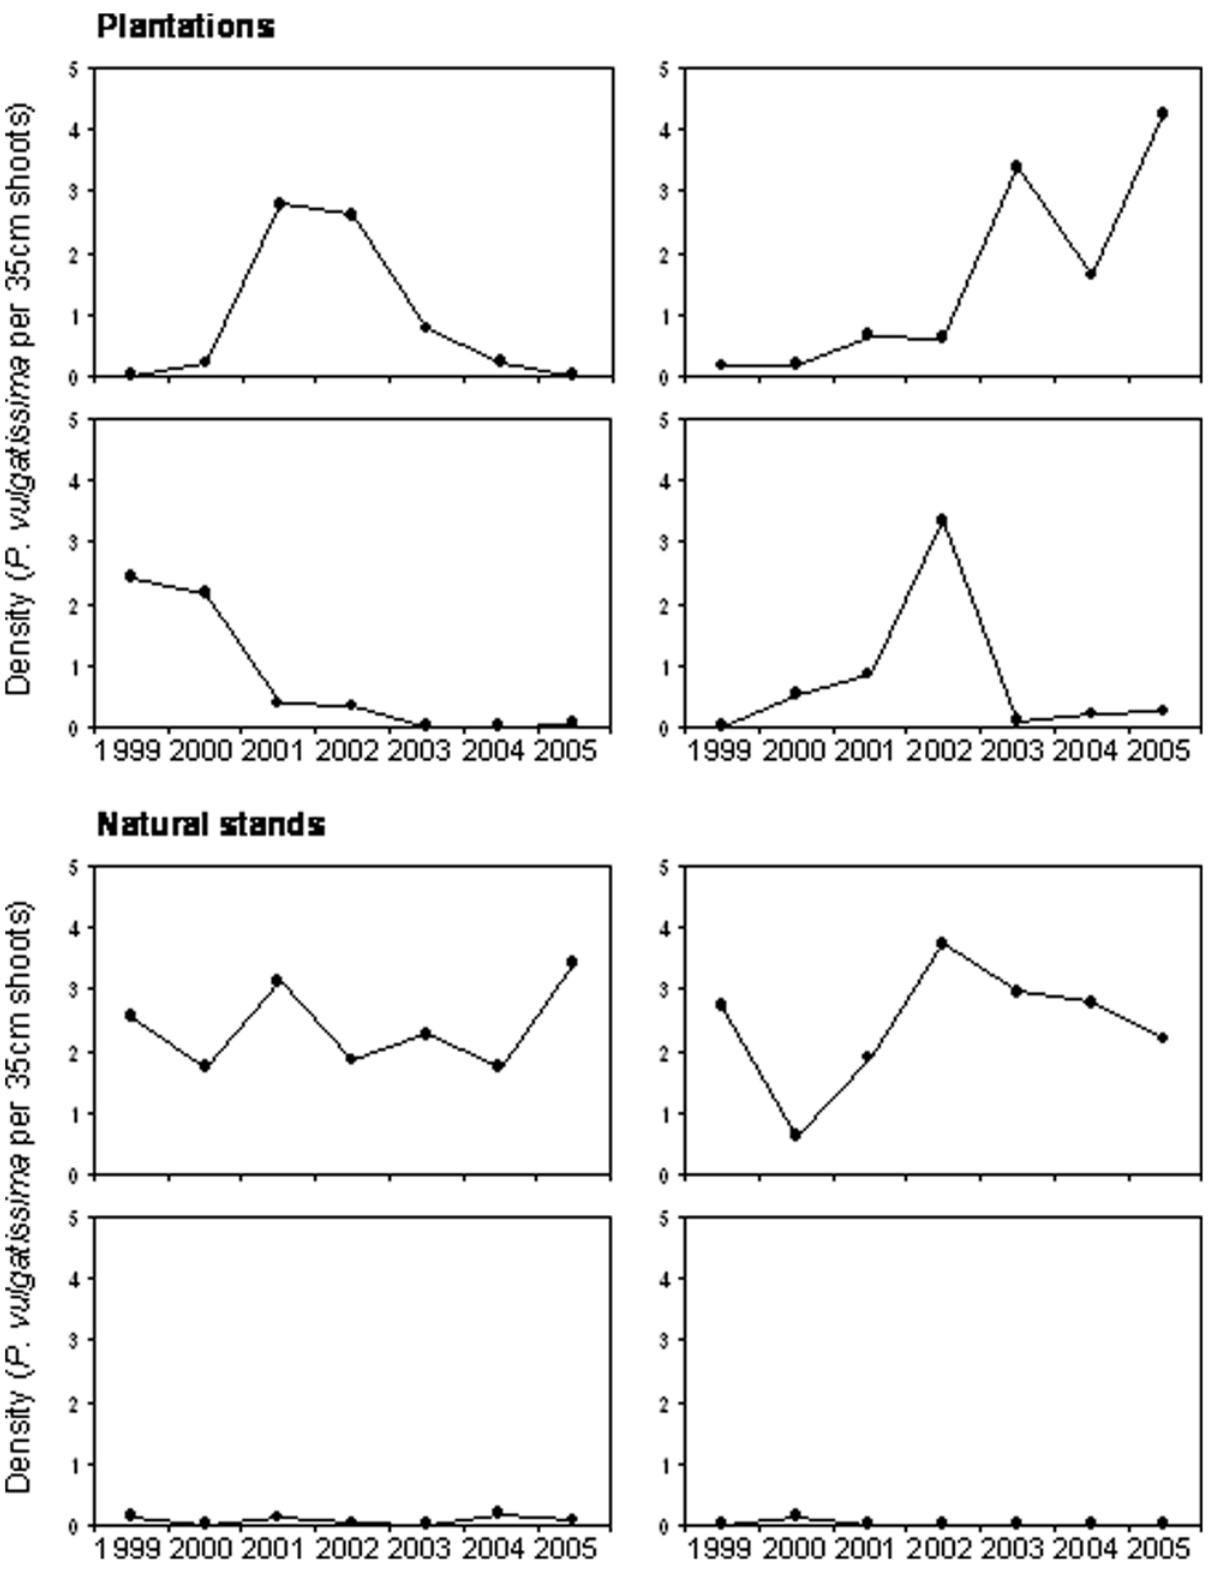
Figure 1. Population dynamics of Phratoravulgatissima in plantations (upper four) and natural stands (lower four) . The four examples from willow plantations represent outbreak dynamics (fluctuations between low and high densities), whereas the examples from natural stands represent fluctuations around relatively stable high (upper two) and low (bottom two) mean densities. Density is measured as the average number of adult beetles per 35 cm willow shoots in the spring.